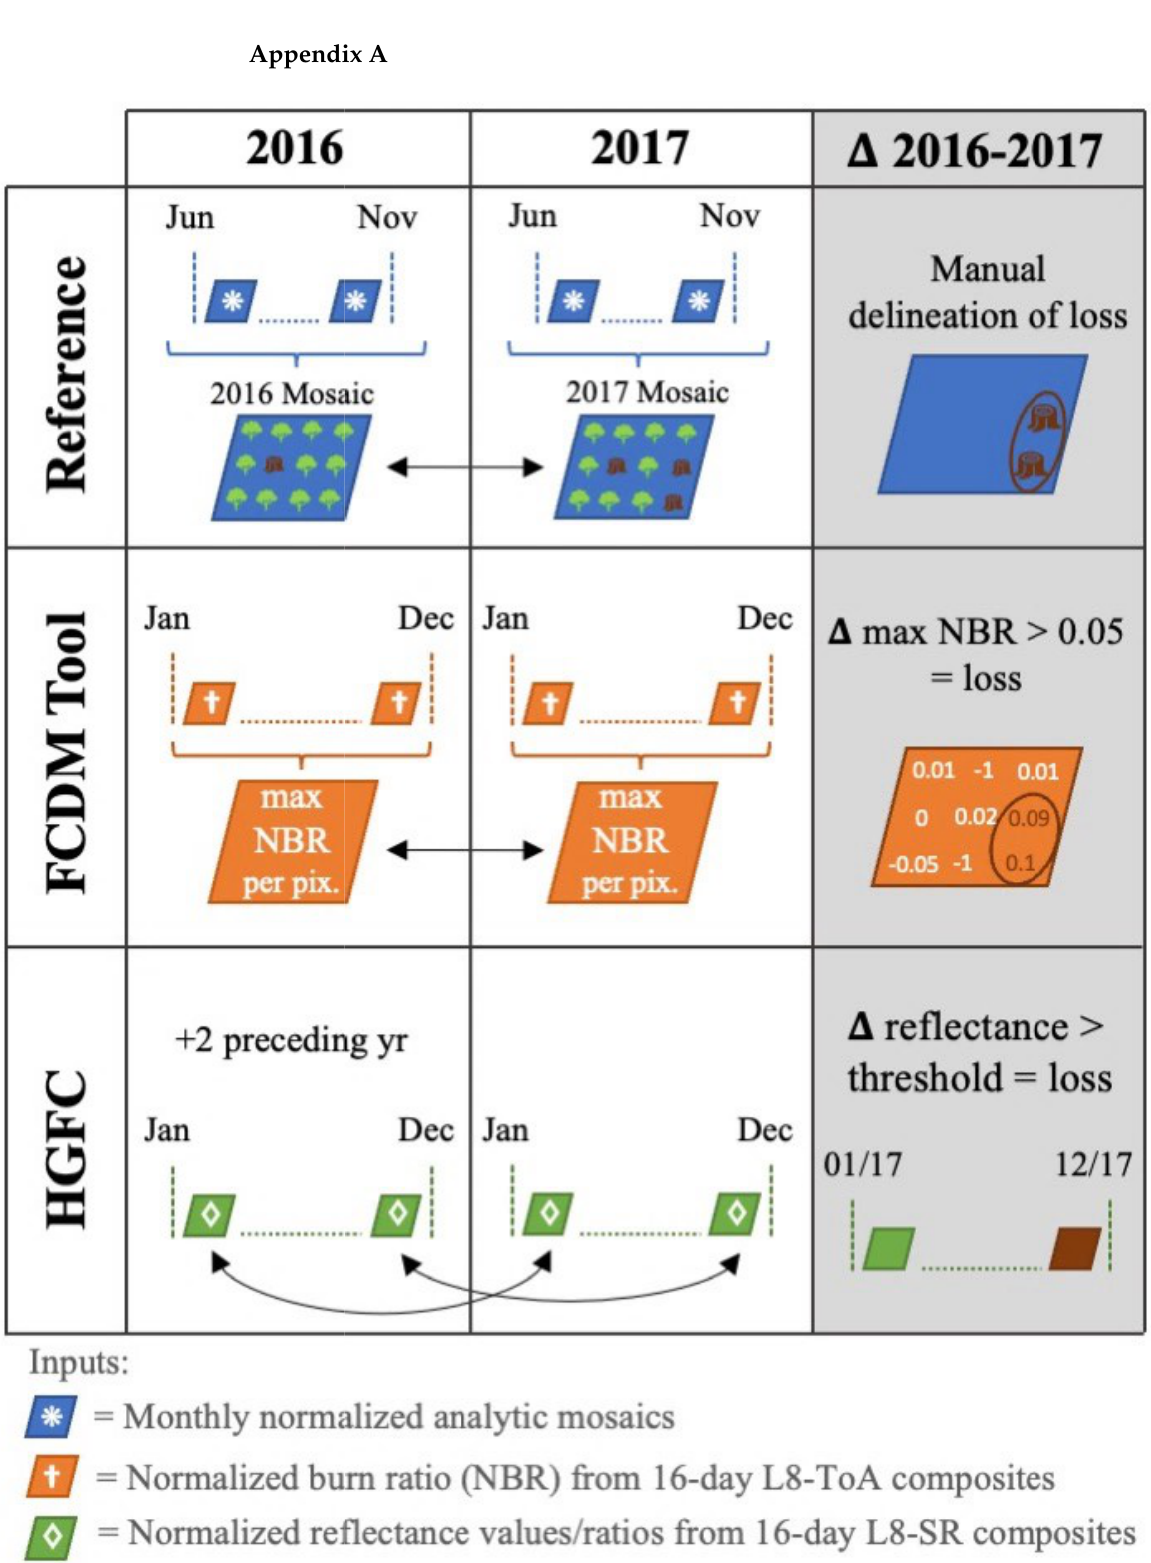
Figure A1. Differences in detection methodology between the three forest loss datasets used in this study, including the reference dataset (Planet/NICFI imagery), FCDM Tool [26], and the Hansen Global Forest Change product